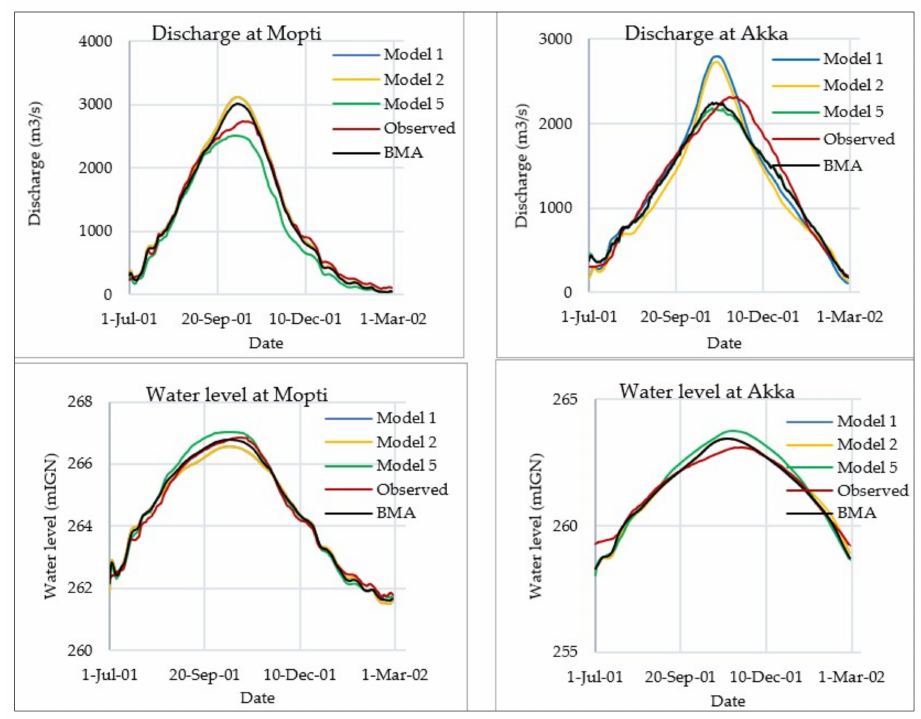
Figure 8. Comparison of discharge ( top ) and water level ( bottom ) of the best models and BMA.